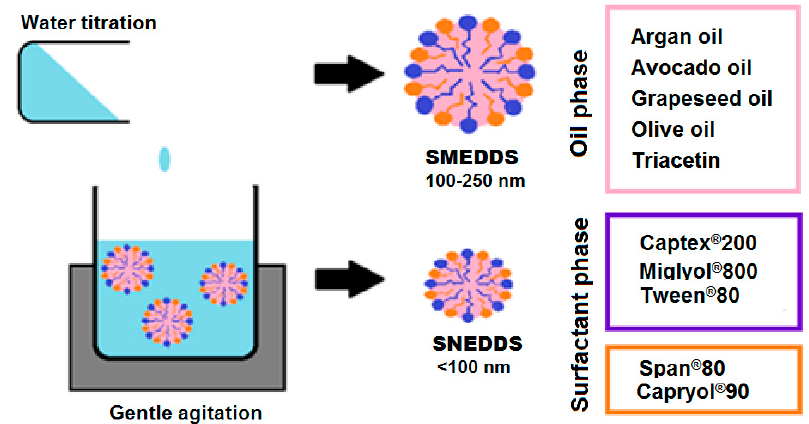
Figure 2. Processes and excipients utilised during the formulation of self-emulsifying drug delivery systems (SEDDSs). SMEDDS = self-micro-emulsifying drug delivery systems and SNEDDS = self-nanoemulsifying drug delivery systems.